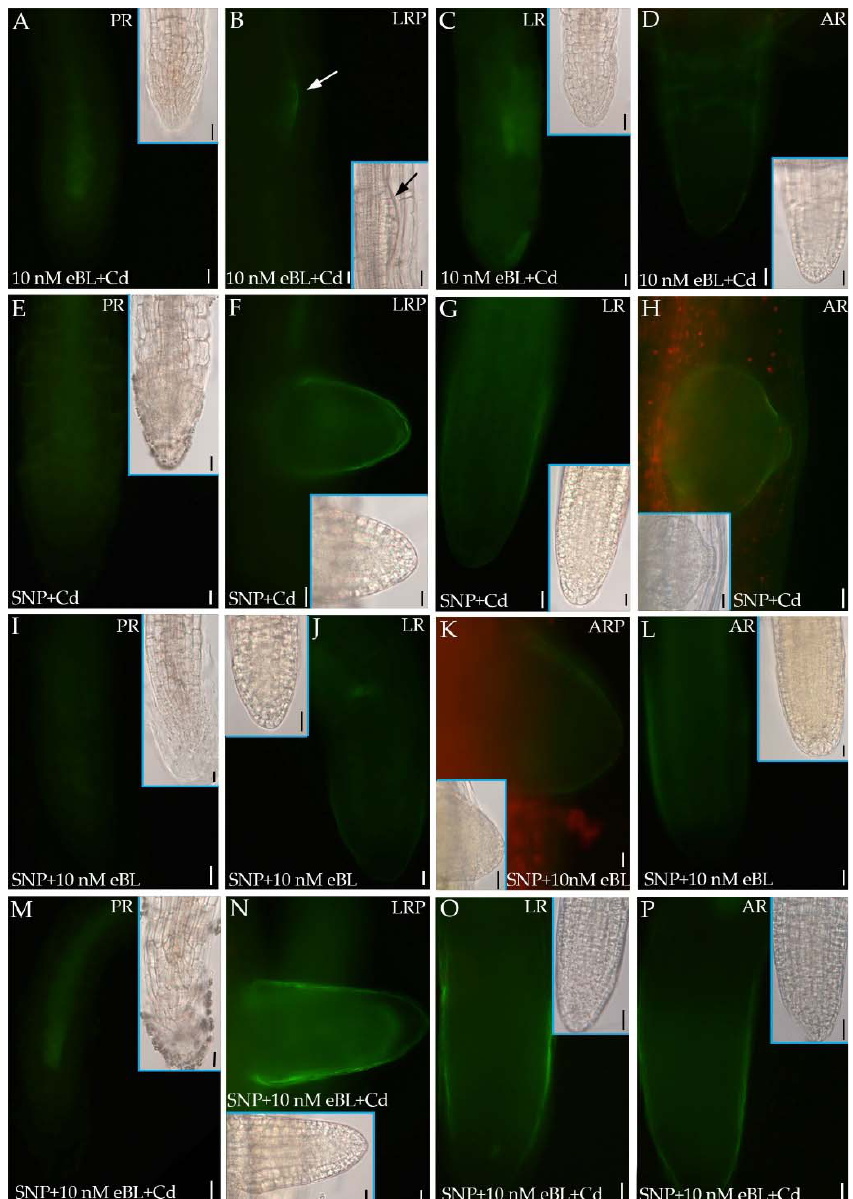
Figure 8. Nitric oxide epifluorescence signal in primary roots (PRs) ( A , E , I , M ), lateral root (LR) primordia (LRP, arrow in B , F , N ), LRs ( C , G , J , O ), ARs ( D , L , P ) and in the adventitious root (AR) primordia (ARP, H , K ), of Col seedlings incubated with DAF ‐ FM DA after culture for 9 days under continuous darkness followed by 7 days under 16 h light/8 h darkness photoperiod on ½ MS medium (see Section 4) plus either 10 nM eBL + 60 μ M CdSO 4 (10 nM eBL + Cd, A – D ), or 50 μ M SNP + 60 μ M CdSO 4 (SNP + Cd, E – H ), or 50 μ M SNP + 10nM eBL (SNP + 10 nM eBL , I – L ), 50 μ M SNP + 10nM eBL + 60 μ M CdSO 4 (SNP + 10nM eBL + Cd, M – P ). Inserts are the same apices under white light. Images from the first replicate. Bars: A – C , E , J ‐ L , N ‐ P and inserts in B , G , I , K = 10 μ m and D , F – I , M and inserts in A , C – F , H , J , O ‐ P = 20 μ m.